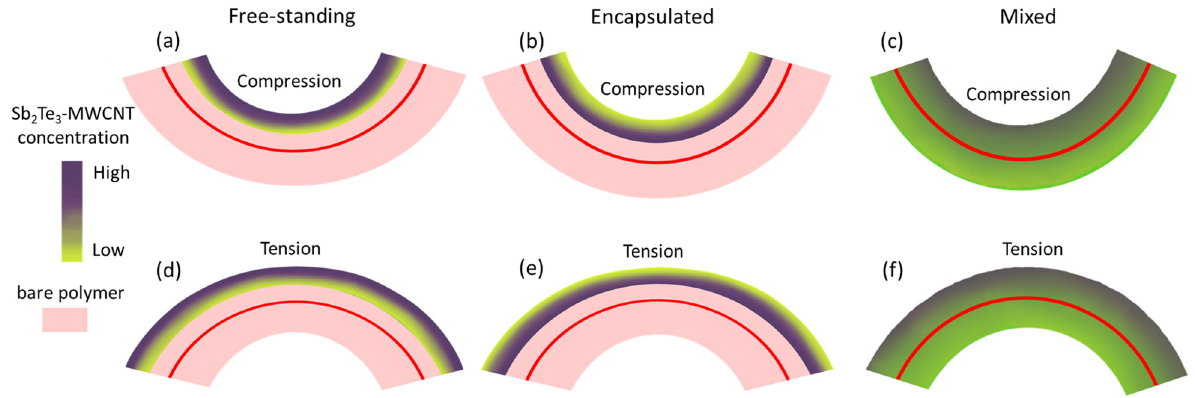
Figure 3. A schematic representation of flexible films with unevenly distributed Sb 2 Te 3 -MWCNT heterostructures, bending in compression or tension mode relatively to the side with the highest concentration of Sb 2 Te 3 : ( a , d ) free-standing on a polyimide substrate; ( b , e ) encapsulated in PDMS; and ( c , f ) mixed with PVA The red line represents the middle line of the